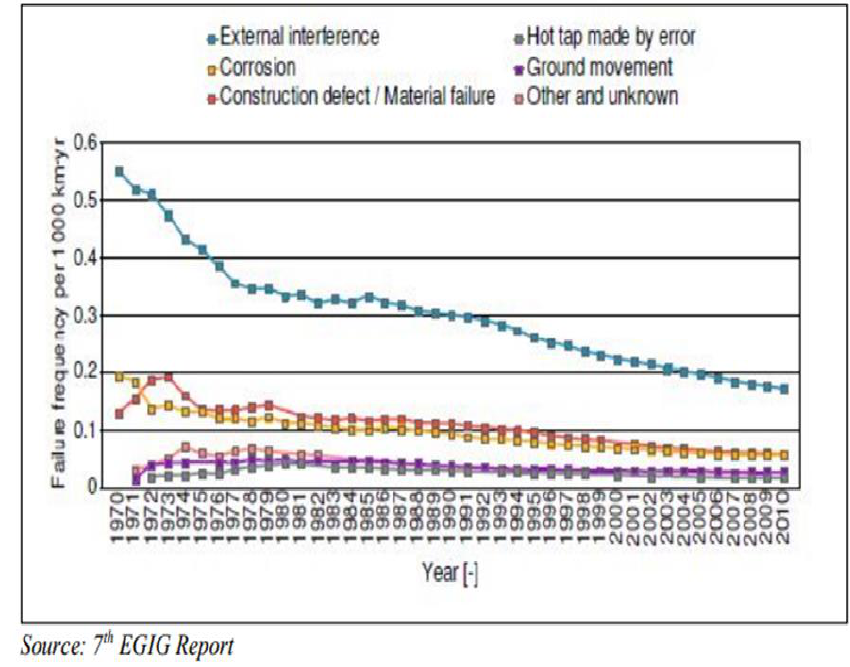
Figure 5. Natural gas pipeline primary failure frequencies per causes.